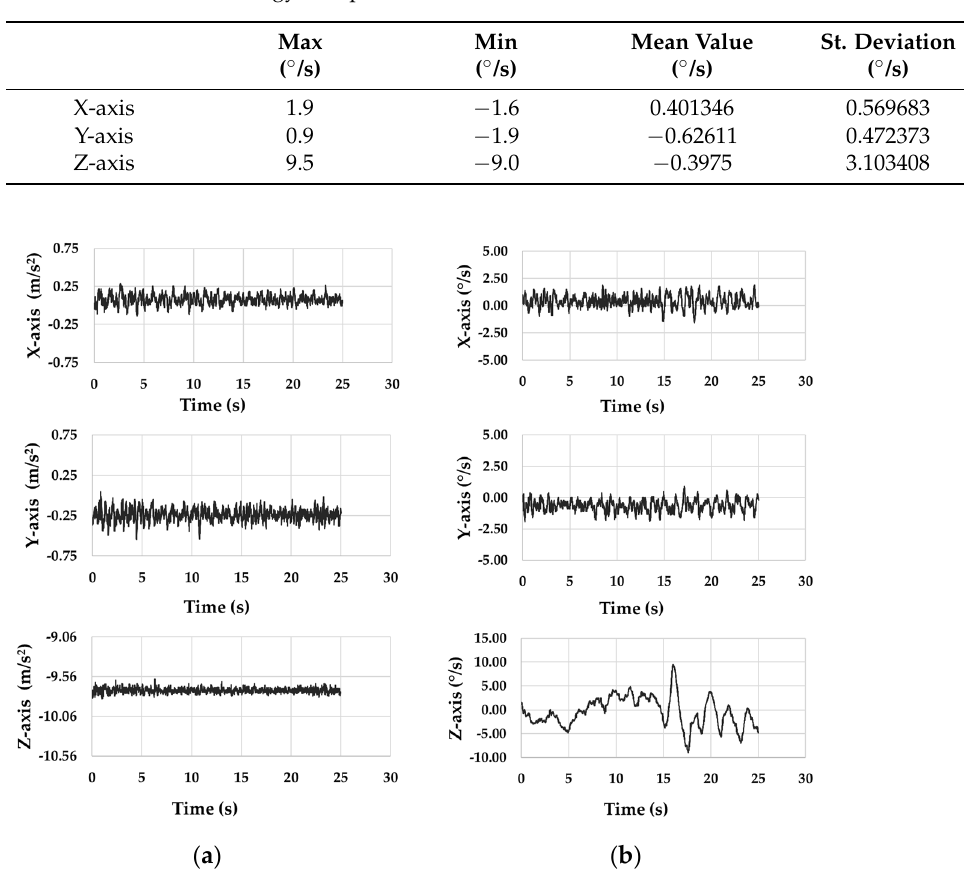
Table 5. Data from triaxial gyroscope in iNEMO inertial module.